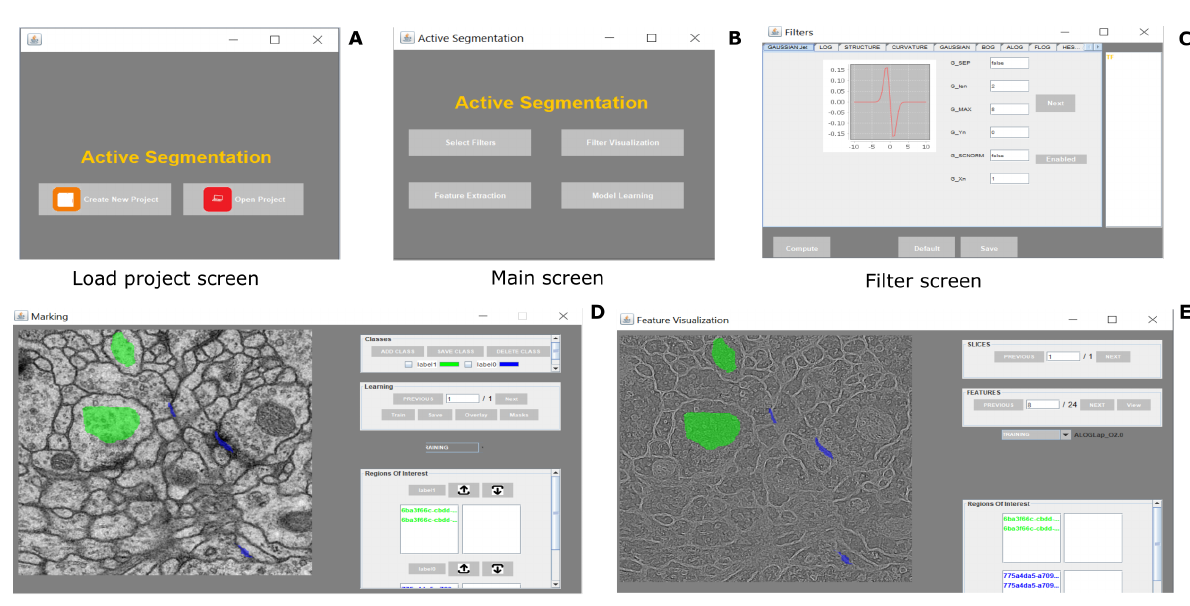
Figure 2. Segmentation and classification functionality of